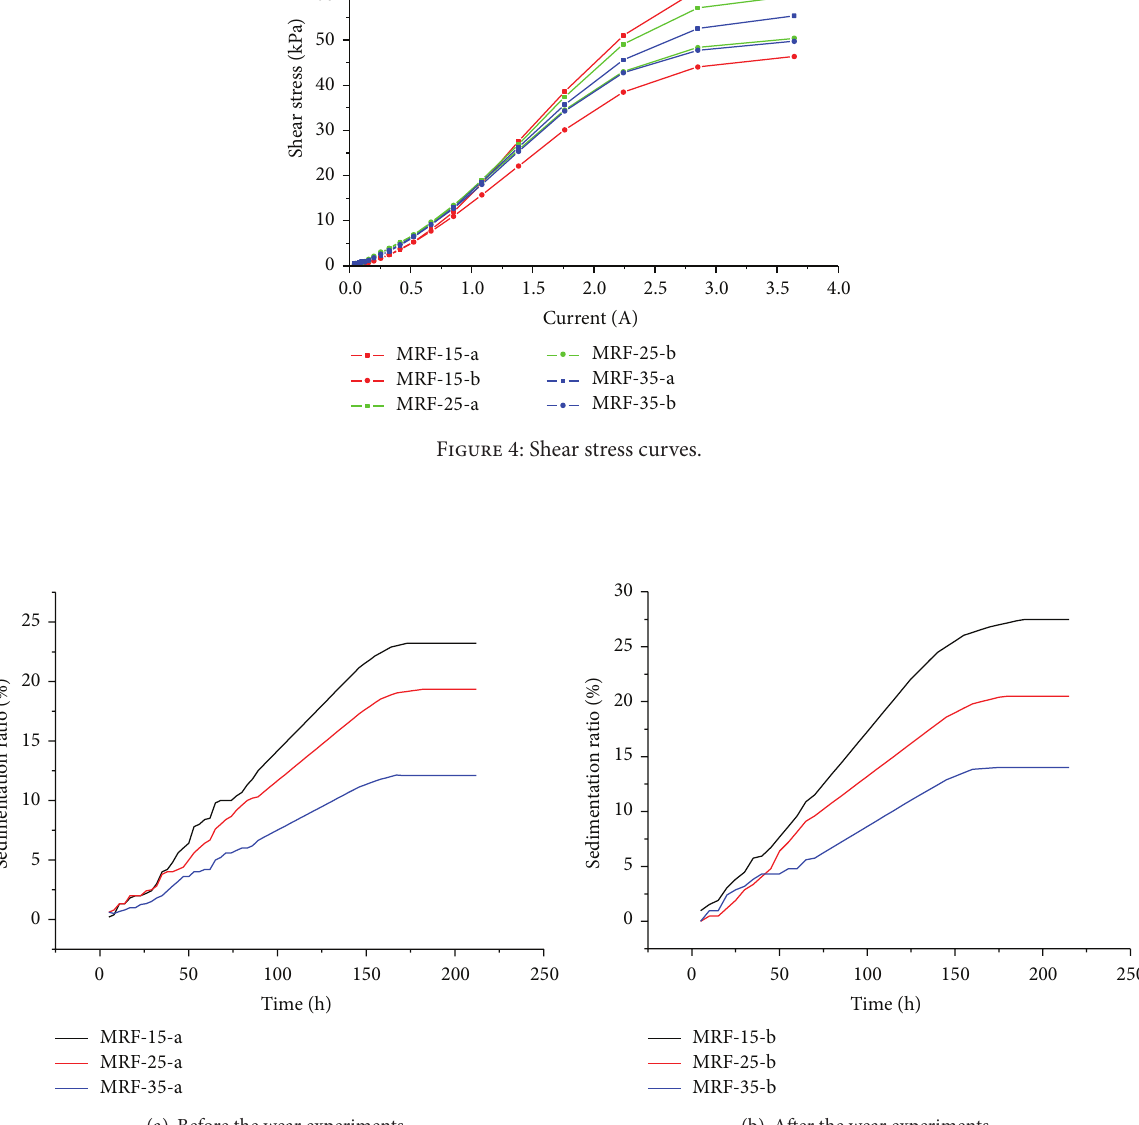
Figure 5: Sedimentation ratio of